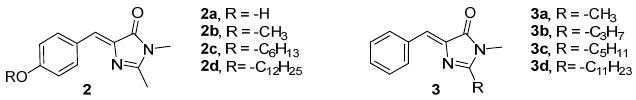
Figure 3. GFPc analogues presenting AIEE properties [10,11].